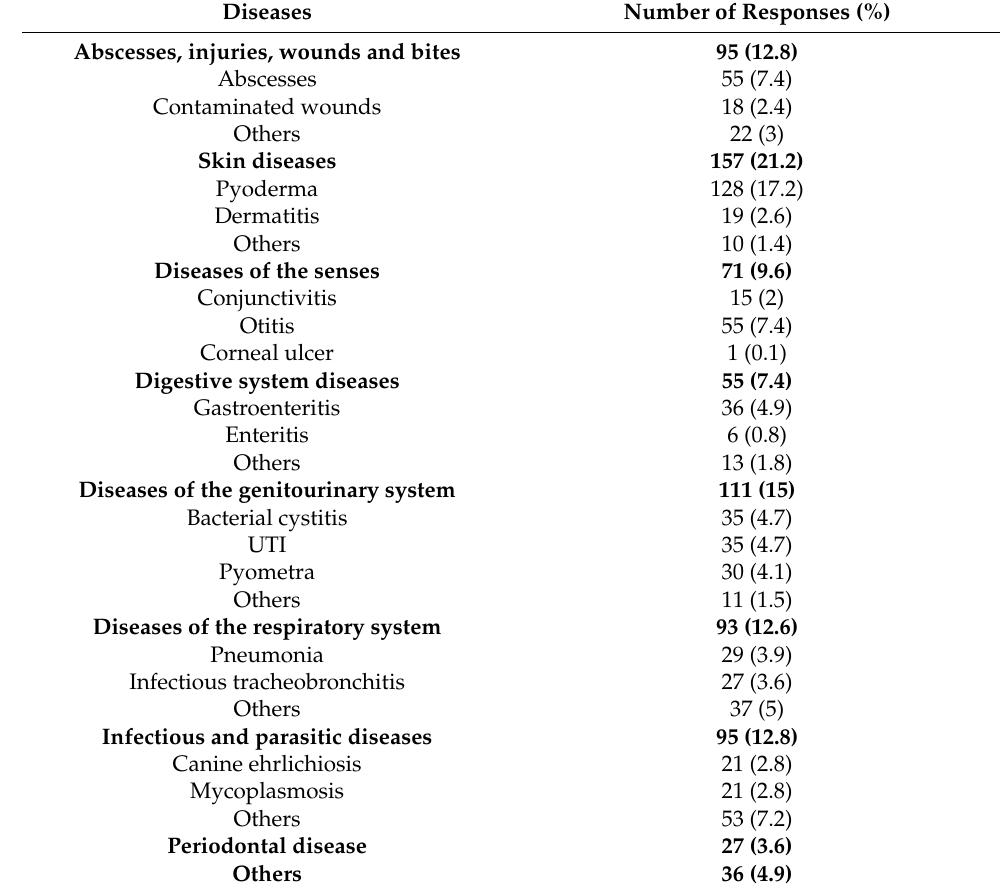
Table 2. Bacterial diseases reported and treated by respondents ( n =